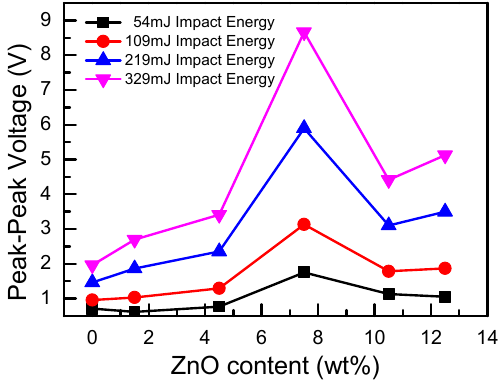
Figure 11. The peak-to-peak voltage versus nano-ZnO dopant under different impact energy.